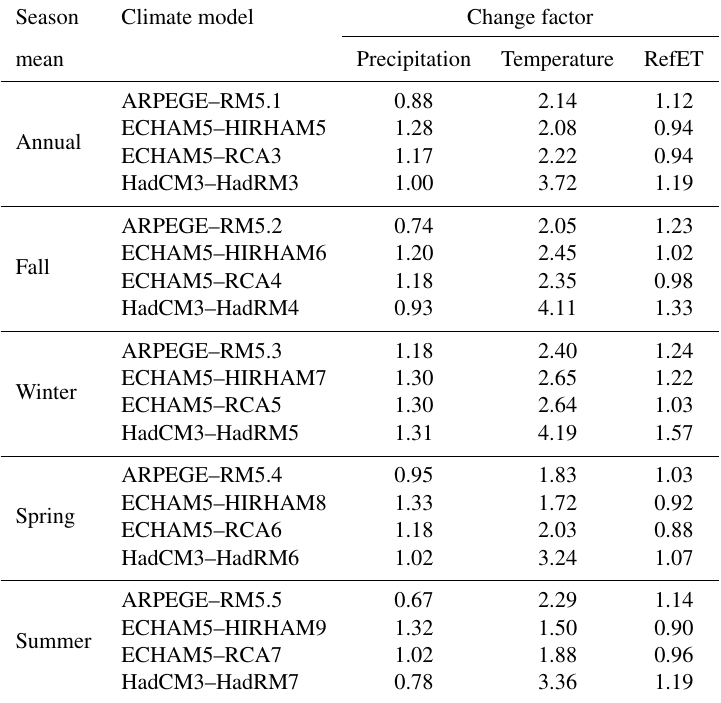
Table 1. Change factor for the four climate model combinations for precipitation (multiplicative), temperature (degrees Celsius – additive) and reference evapotranspiration (RefET –